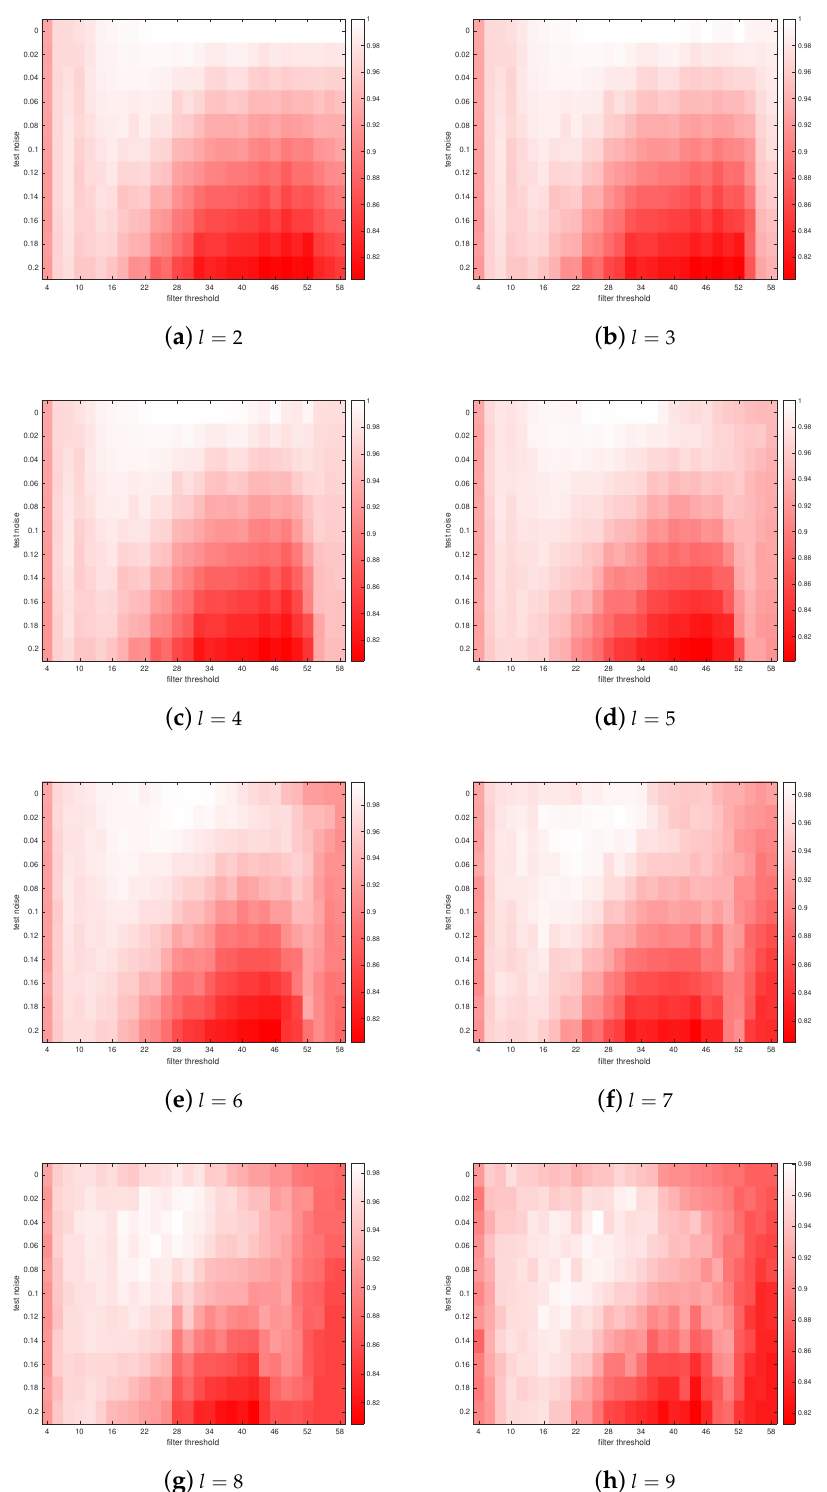
Figure 4. Performance score C p for digit two with various astrocytic coverage areas. In each sub- figure, the vertical axis denotes various levels of the salt-and-pepper noise at the testing stage. The horizontal axis denotes the threshold f 0 (increased by 2 units) of the low-pass